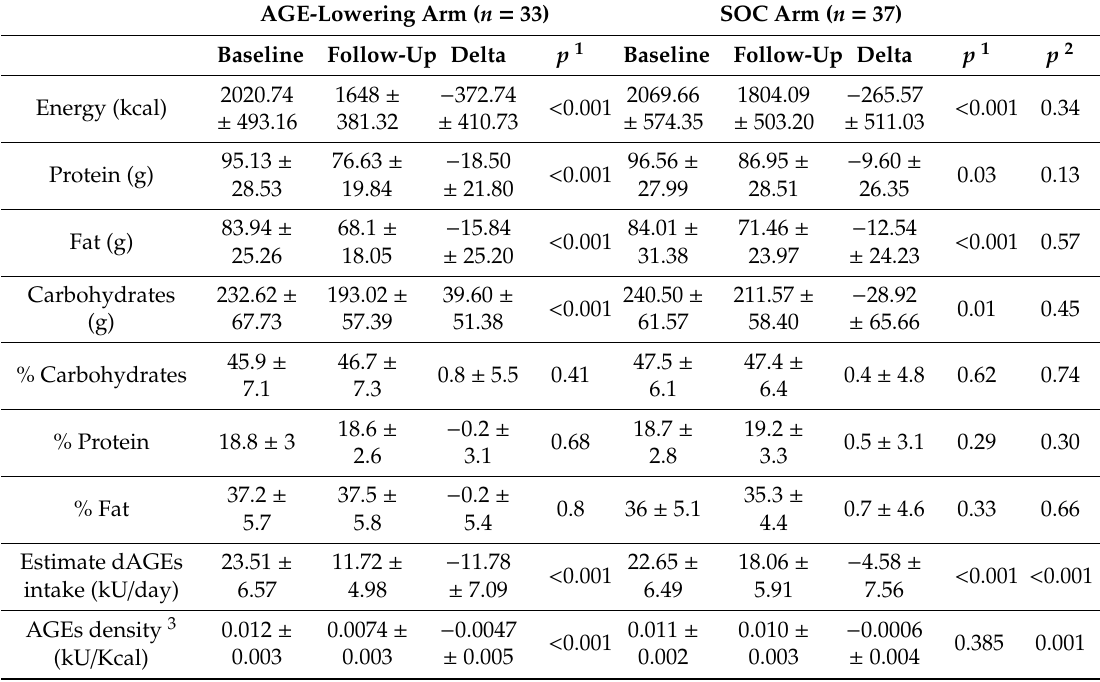
Table 2. Nutritional intake at baseline and